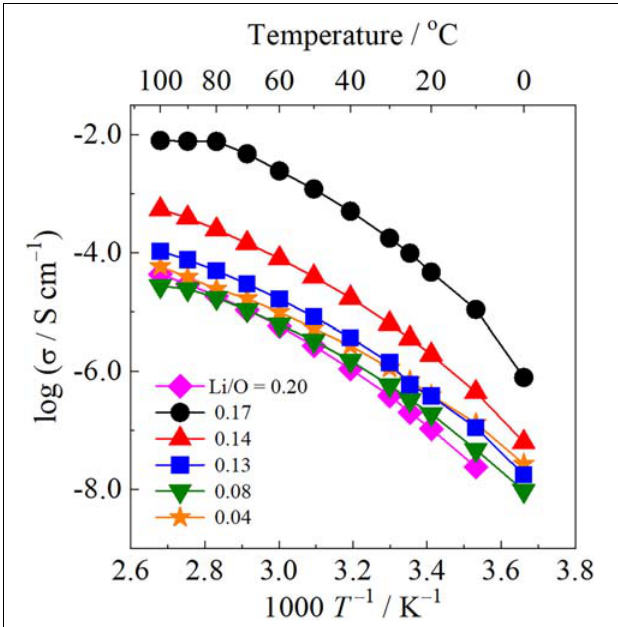
FIGURE 8 | Arrhenius plots of ionic conductivities for SME/LiTFSA composites.